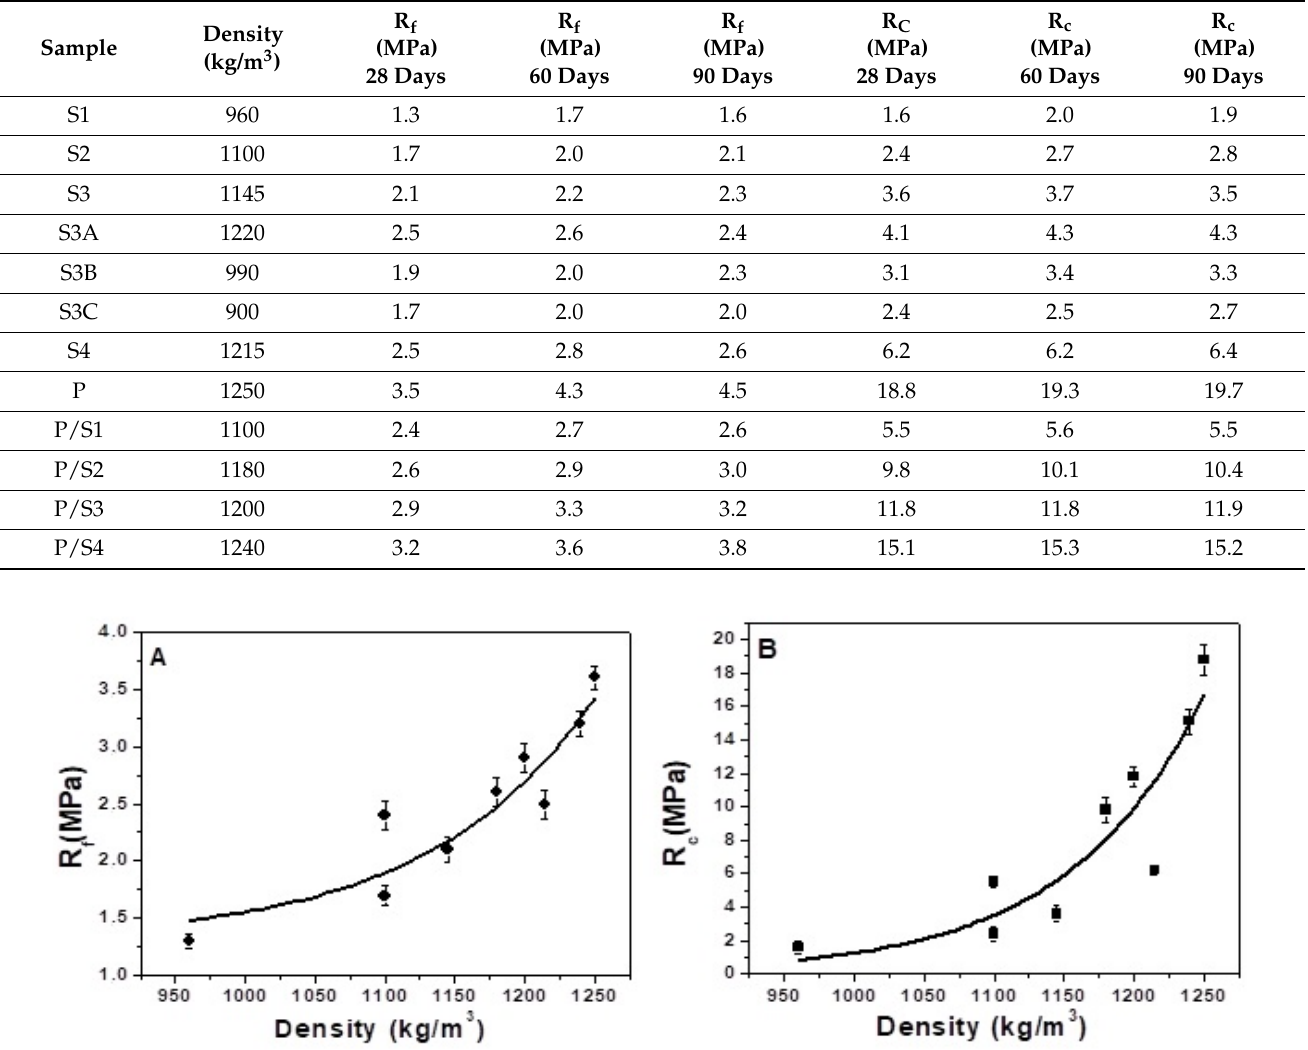
Table 3. Flexural and compressive strengths of the S, P and S/P mortars at 28, 60 and 90-days curing.